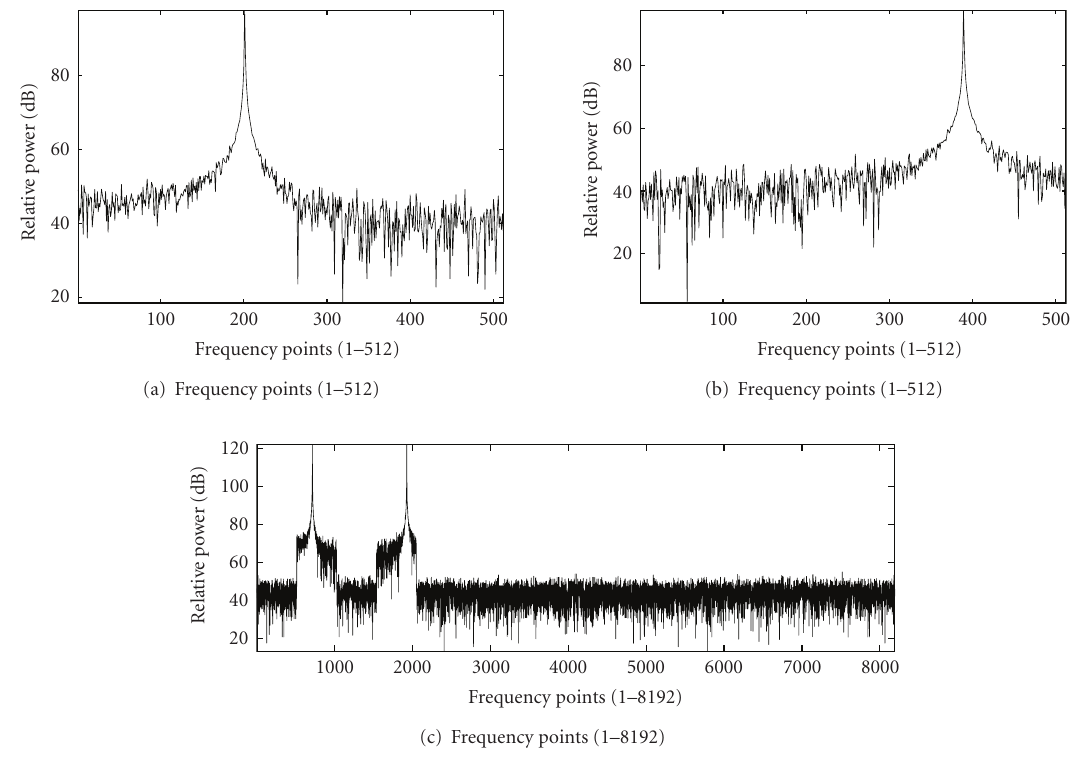
Figure 7: Demonstration of proposed modulating interpolation.